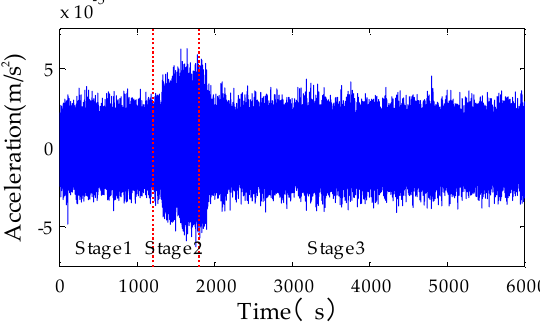
Figure 6. Time history of acceleration response at m 2 .